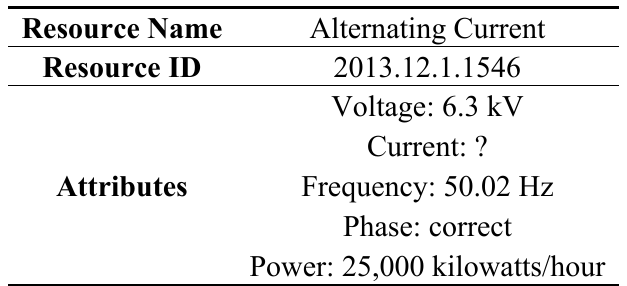
Table 3. A Resource Instance Notation (RIN) sample generated from the